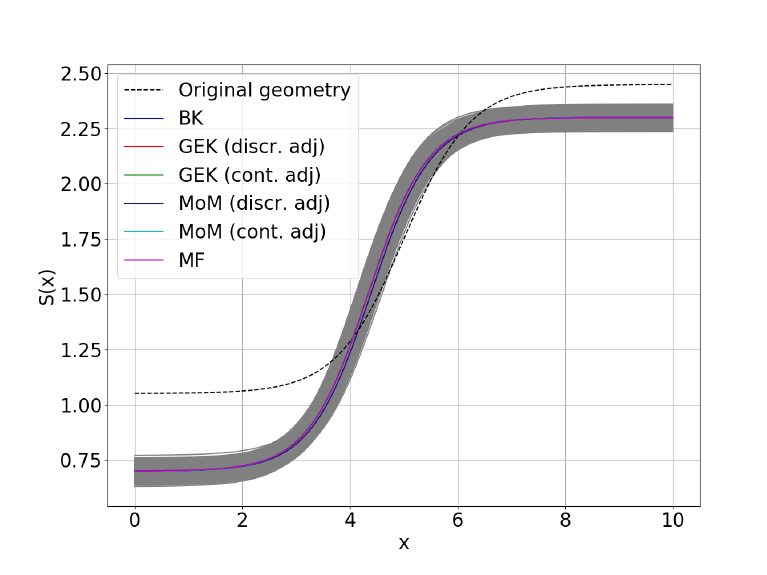
Figure 8. Baseline geometry and optimized geometries (with 3 σ uncertainty intervals) for various RDO